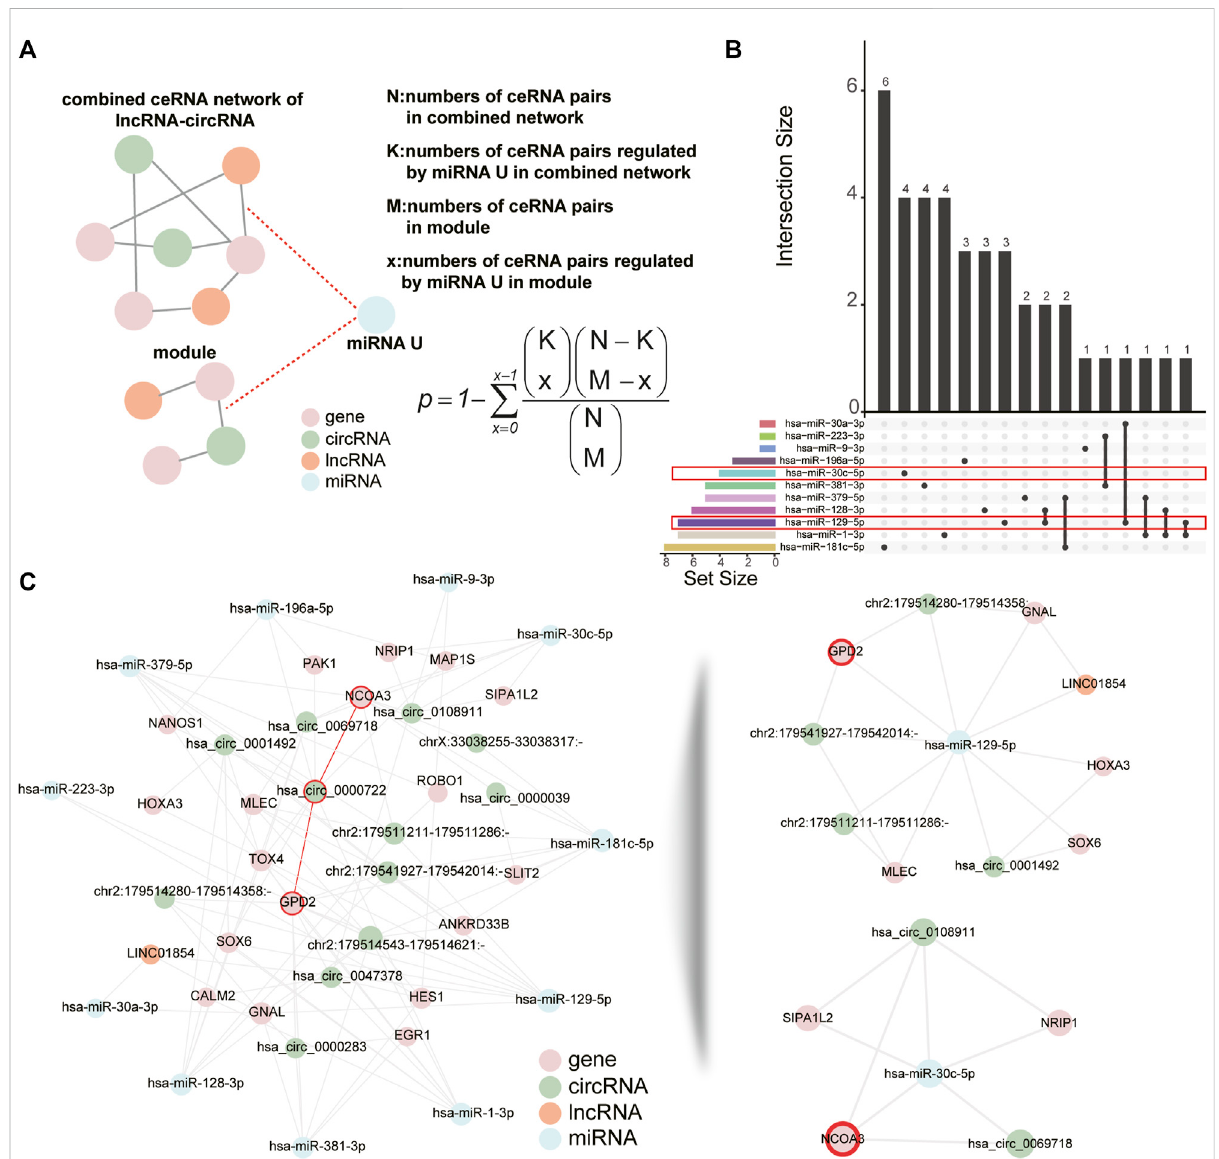
FIGURE 6 Critical miRNAs associated with the module. (A) Schematic of identifying critical miRNAs that signi fi cantly regulate lncRNA/circRNA-mRNA pairs in the module. Dashed lines denote miRNA targeting relationship and brown solid lines denote ceRNA relationship. (B) The UpSet plot demonstratesoverlapinlncRNA/circRNA-mRNApairswhicharemediatedbymiRNAsintheceRNAmodule.The2criticalmiRNAsarehighlightedin red. (C) VisualizationofthemodulewithmiRNAs(leftpanel)andlncRNA/circRNA-mRNApairsregulatedbythetwocriticalmiRNAs(rightpanel). The circRNA-mRNA pairs and mRNAs related to hsa_circ_0000722 are highlighted in